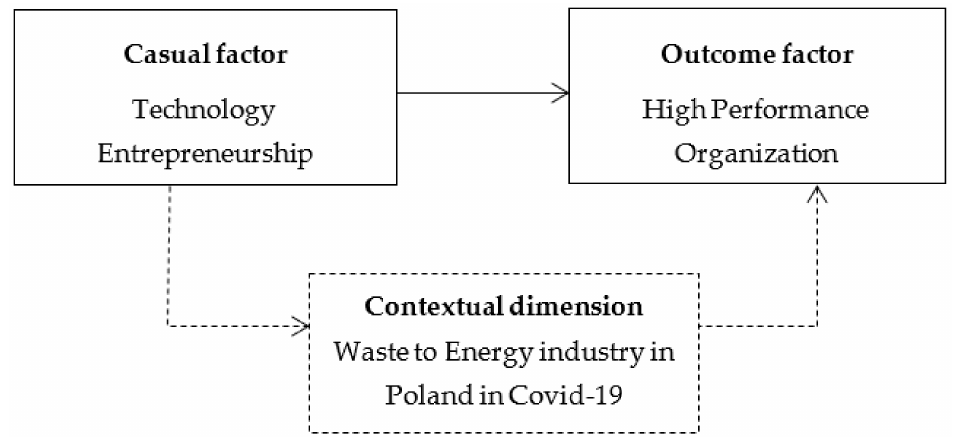
Figure 2. The conceptual research